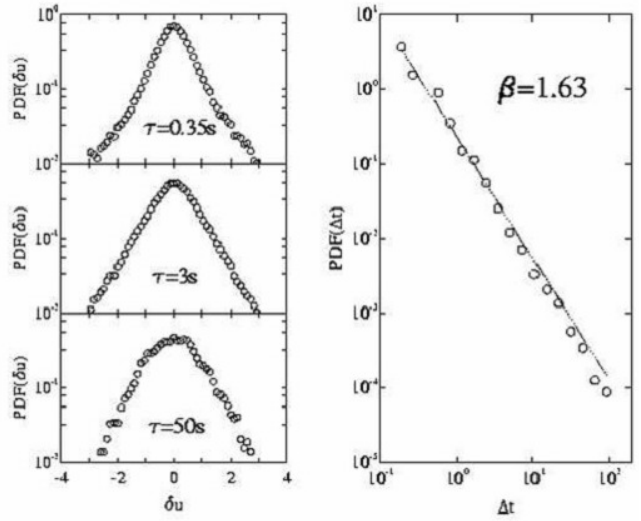
Figure 83: Left panel: normalized PDFs of velocity fluctuations in atmospheric turbulence. Right panel: distribution function of waiting times Δ 𝑡 between structures at the smallest scale. The parameter 𝛽 is the scaling exponent of the scaling relation PDF(Δ 𝑡 ) ∼ Δ 𝑡 − 𝛽 for the distribution function of waiting times. The turbulent samples have been collected above a grass-covered forest clearing at 5 m above the ground surface and at a sampling rate of 56 Hz (Katul et al. ,